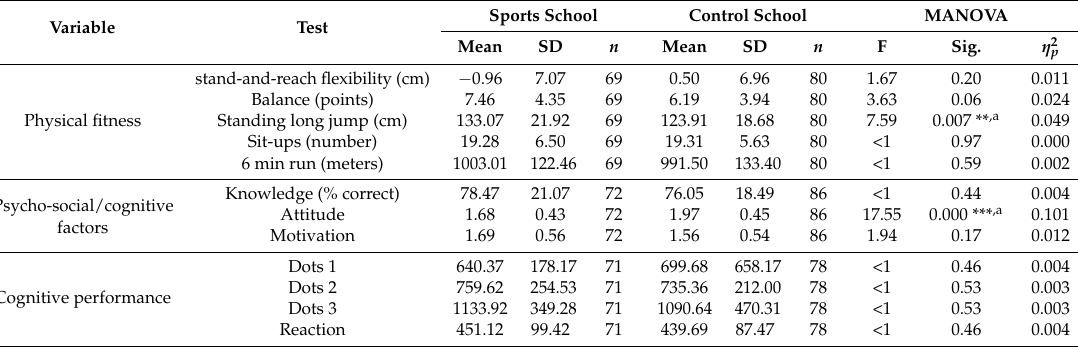
Table 3. Means and standard deviations of the two schools at T2 and corresponding between-group results of the respective